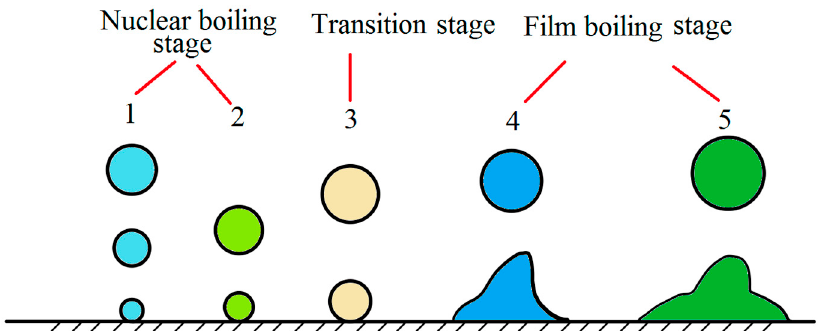
Figure 15. Schematic diagram of steel wire water bath quenching. Reprinted with permission from ref. [23]. ref.